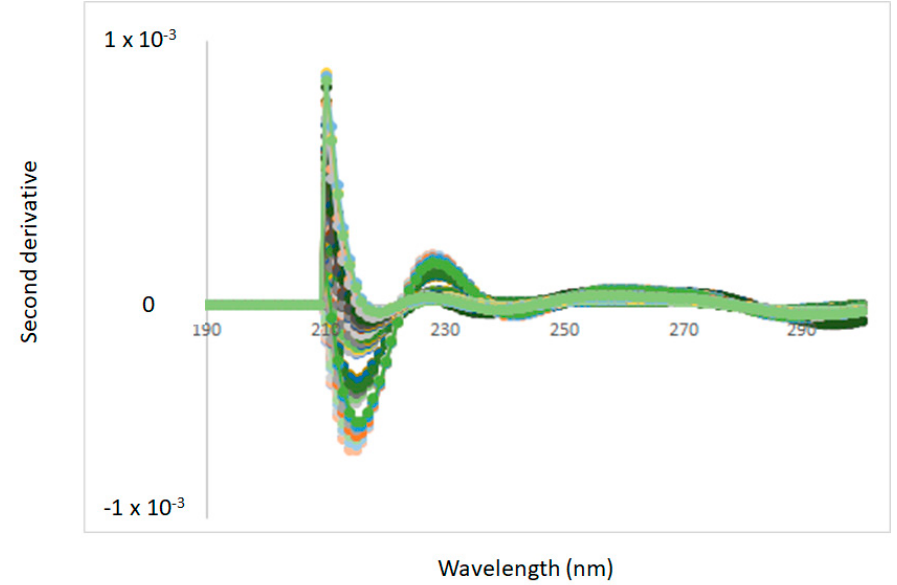
Figure 1. UV-VIS spectra of whisky samples scanned at different temperatures (25, 35, 45, and 55 °C) in transmission.